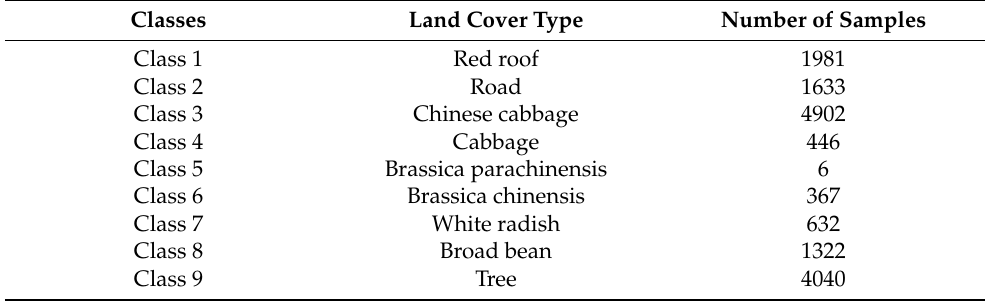
Figure 4. The WHU-Hi-HongHu dataset. ( a ) RGB image (band 1,30,60). ( b ) Reference land-cover Figure 4. The WHU ‐ Hi ‐ HongHu dataset. ( a ) RGB image (band 1,30,60). ( b ) Reference land ‐ cover map (nine classes). map (nine classes). Table 3. Land cover classes with the number of samples for Pavia University